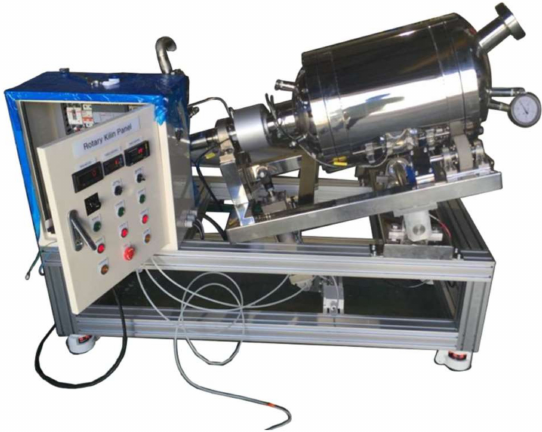
Figure A2. Bench scale ball milling pretreatment reactor setup for ball-milling organosolv